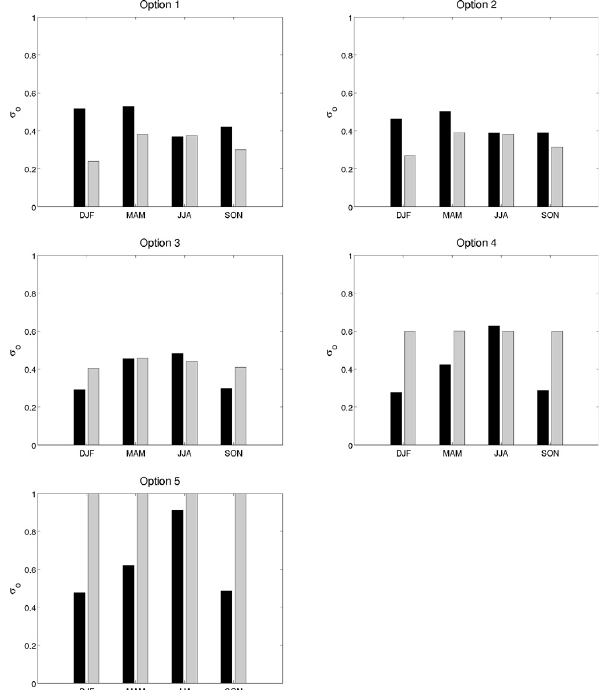
Fig. 9. As in Fig. 8, except for observation